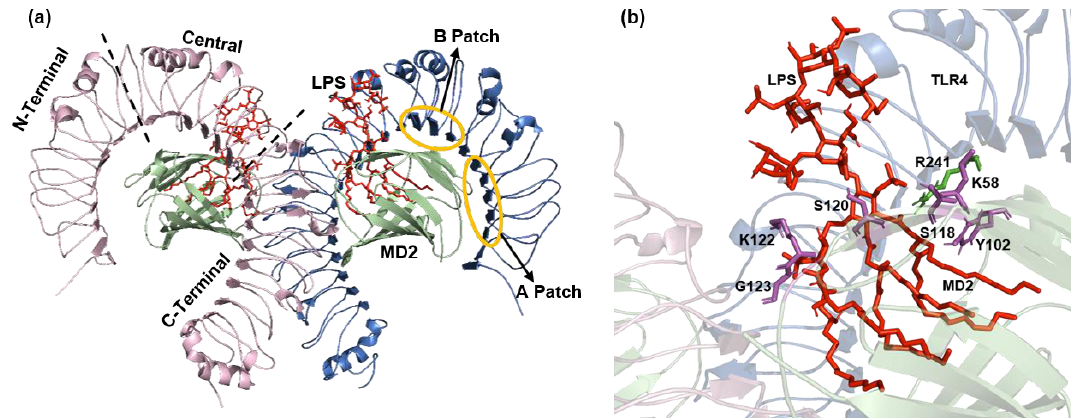
Figure 2. TLR4-MD2-LPS complex (PDB ID: 3FXI). ( a ) The ECD is divided into three subdomains: N-